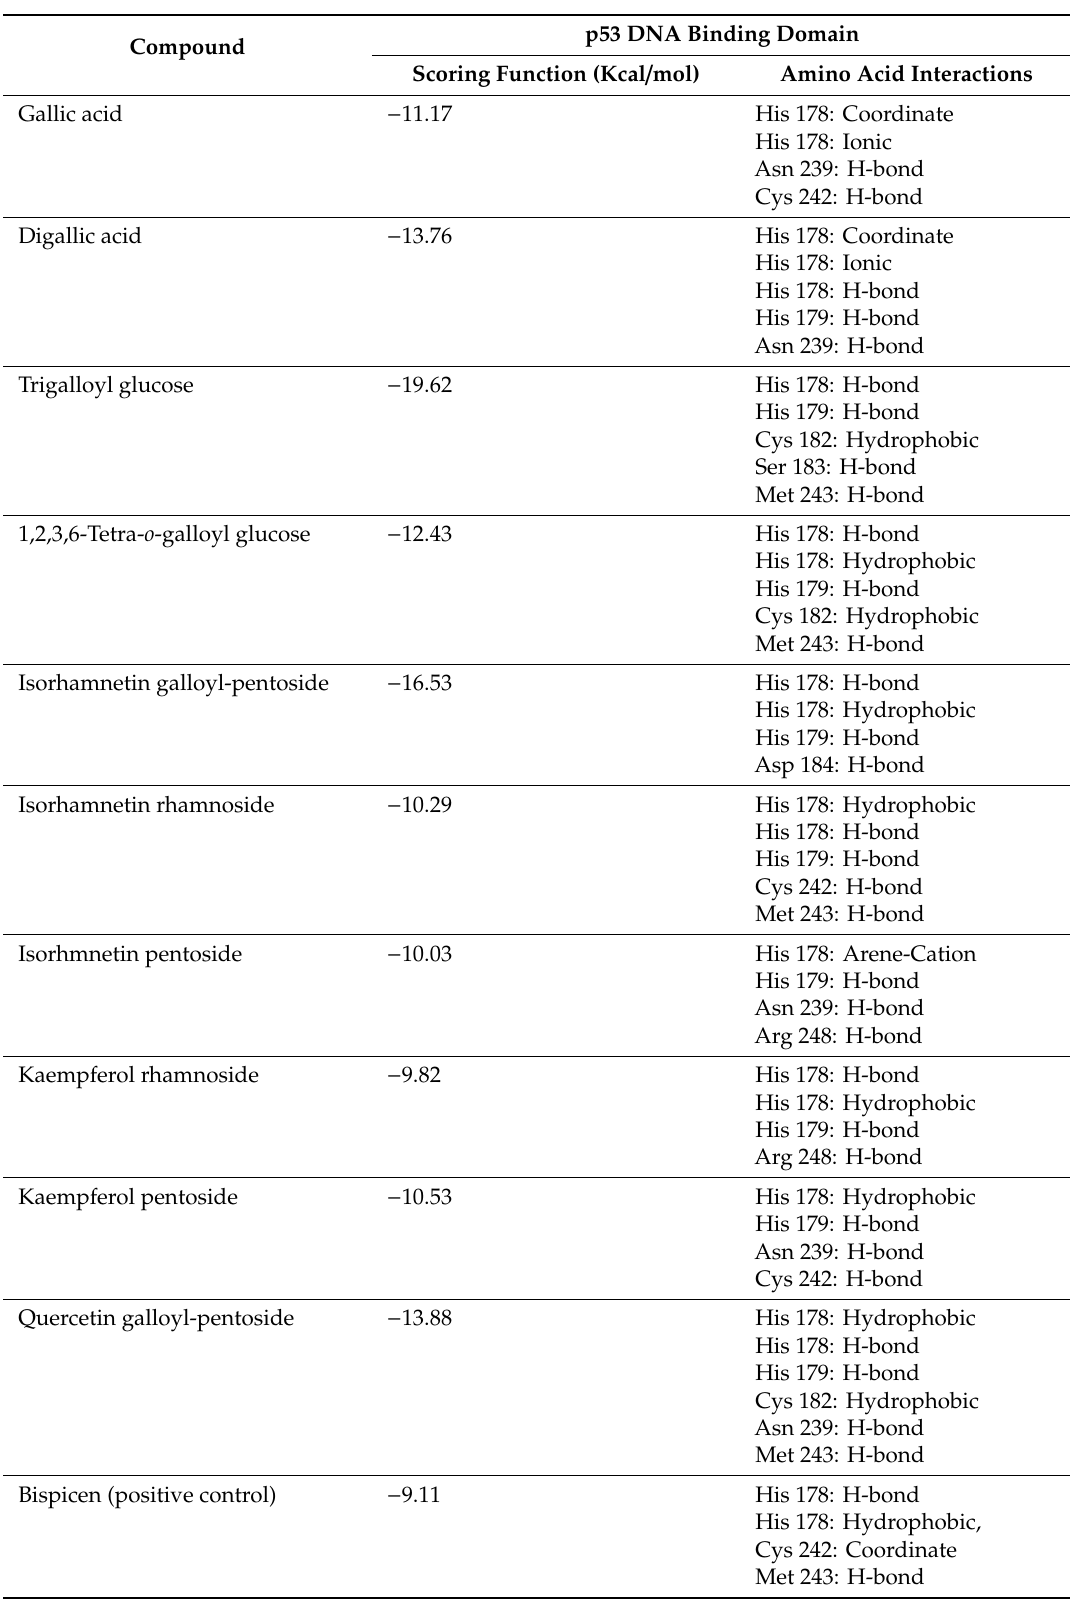
Table 5. Amino acid interactions and scoring functions of the compounds from H. campechianum flower extract docked into the p53 DNA binding